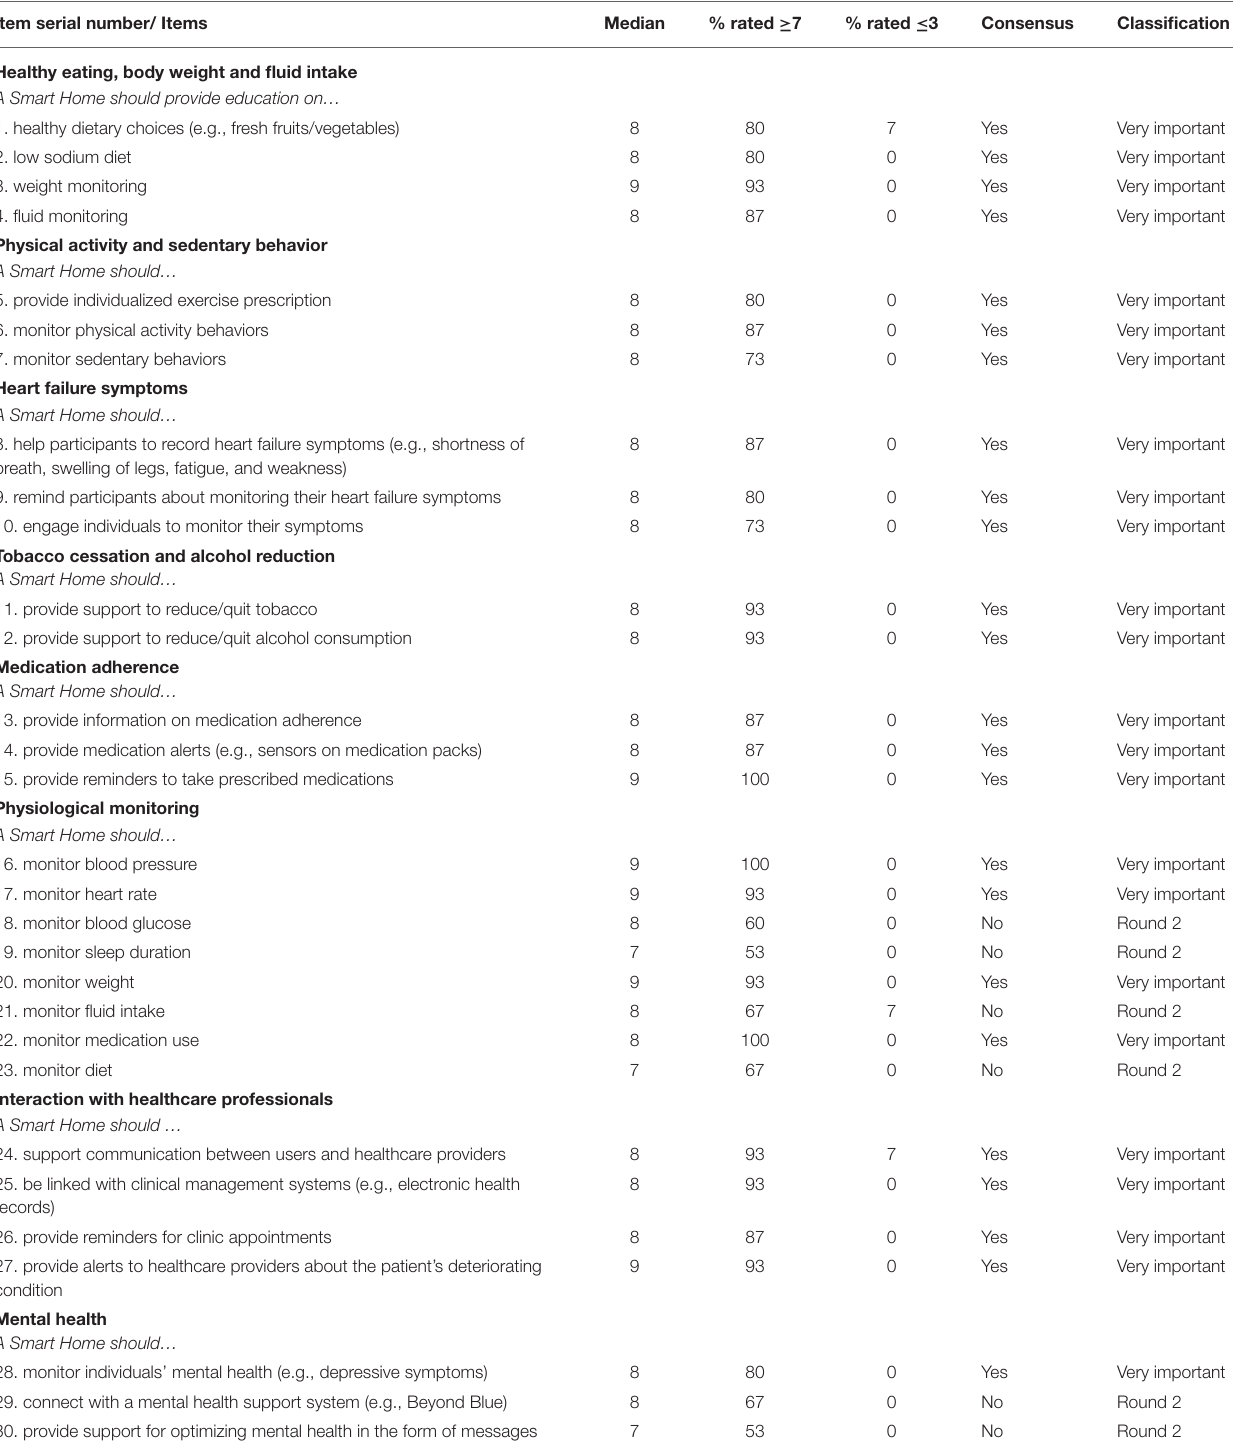
TABLE 1 | Delphi survey round 1 scoring and classification. Item serial number/ Items